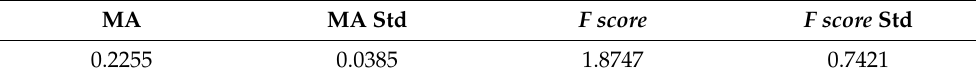
Table 1. Matching Accuracy (MA) and F score for Real Data Matching MA MA Std